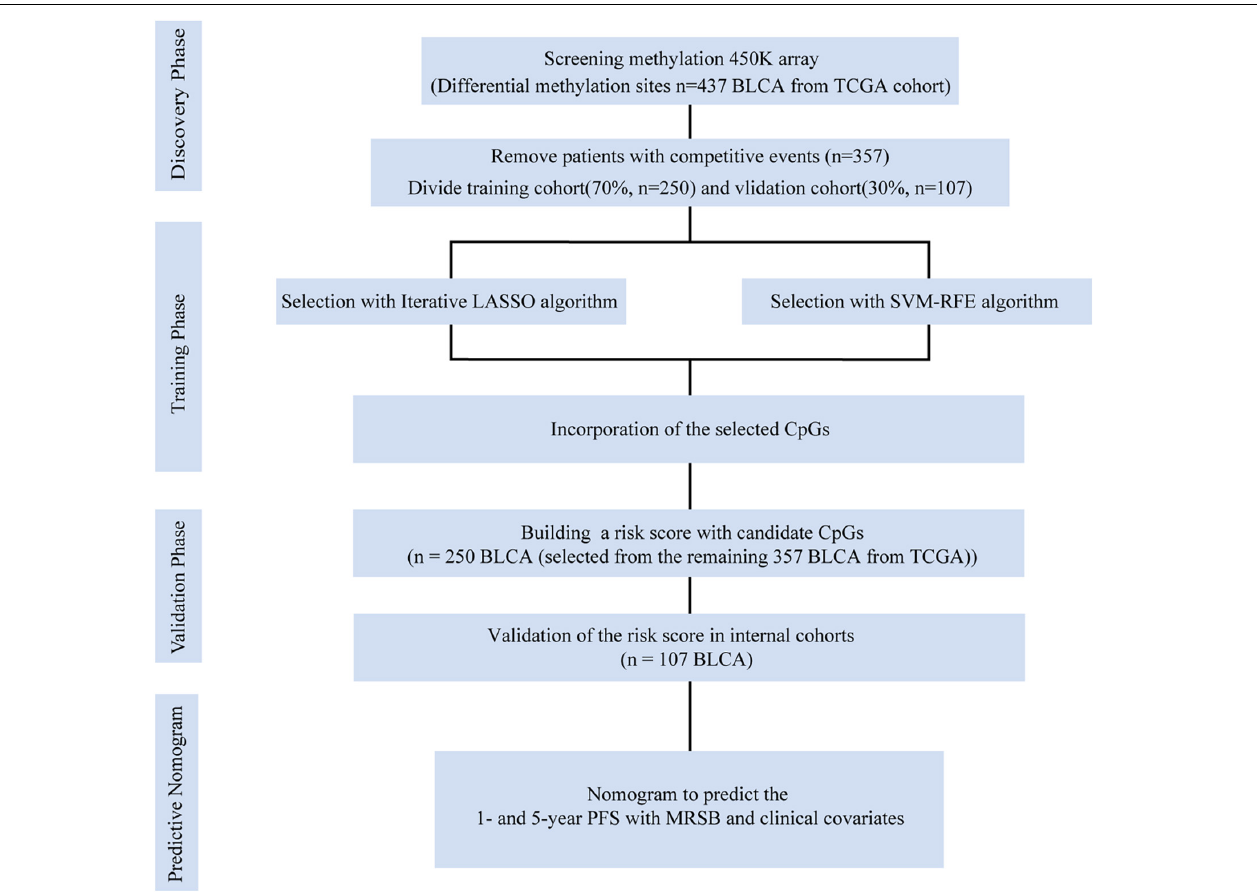
FIGURE 1 | Data generation and analysis process of this study. The differentially presented CpGs between cancer and normal tissues in the TCGA bladder cancer cohort were firstly identified. After excluding competitive event patients, SVM-RFE and LASSO algorithms were used to identify candidate methylation sites and to incorporate the results. Multivariate Cox analysis was performed to establish the prognostic model: the MRSB was validated in the internal validation cohort. Finally, nomograms were established with MRSB and clinical covariates. TCGA, The Cancer Genome Atlas; SVM-RFE, support vector machine-recursive feature elimination; LASSO, least absolute shrinkage and selector operation; BLCA, bladder cancer; MRSB, methylation risk score for bladder